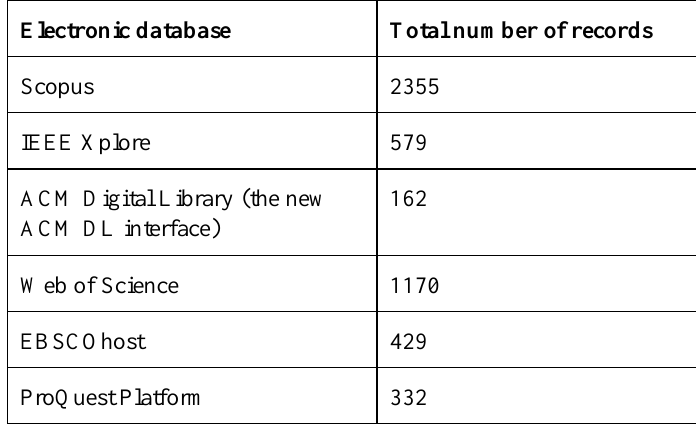
Table 3. Retrieved number of records in each